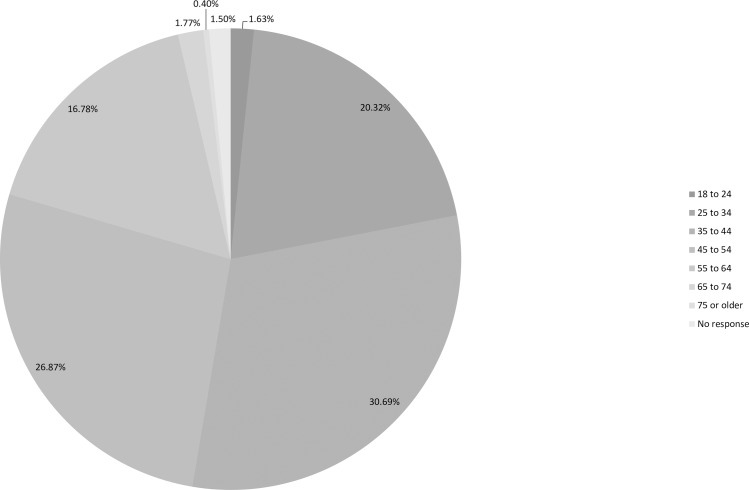
Age distribution of participants (S1 Table).